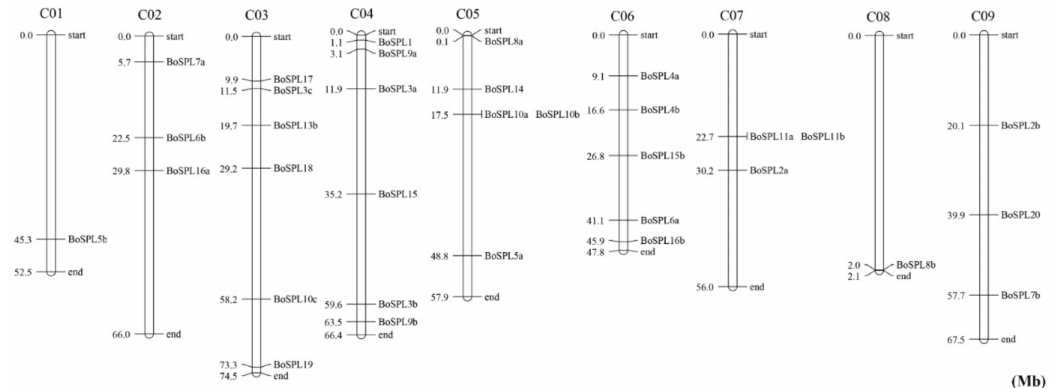
Figure 2. Distribution of BoSPL genes on nine B. oleracea chromosomes. The orthologous and paralogous SPL genes relationships among B. oleracea , B. rapa and A. thaliana were analyzed using the BRAD database, the identified collinear and relationships of gene pairs in the SPL s are shown in Figure 3. A total of 27 orthologous SPL gene pairs between B. oleracea and B. rapa , 29 orthologous SPL gene pairs between B. oleracea and A. thaliana and 14 paralogous SPL gene pairs were identified in B. oleracea . Except for the loss of BoSPL12, all the BoSPLs were retained after the whole genome triplication event (WGT) and fractionation. Ten BoSPL genes ( BoSPL2, 4, -5, 6, -7, -8, -9, -11, -15, -16, ) retained double copies, BoSPL3 and BoSPL10 retained three copies.